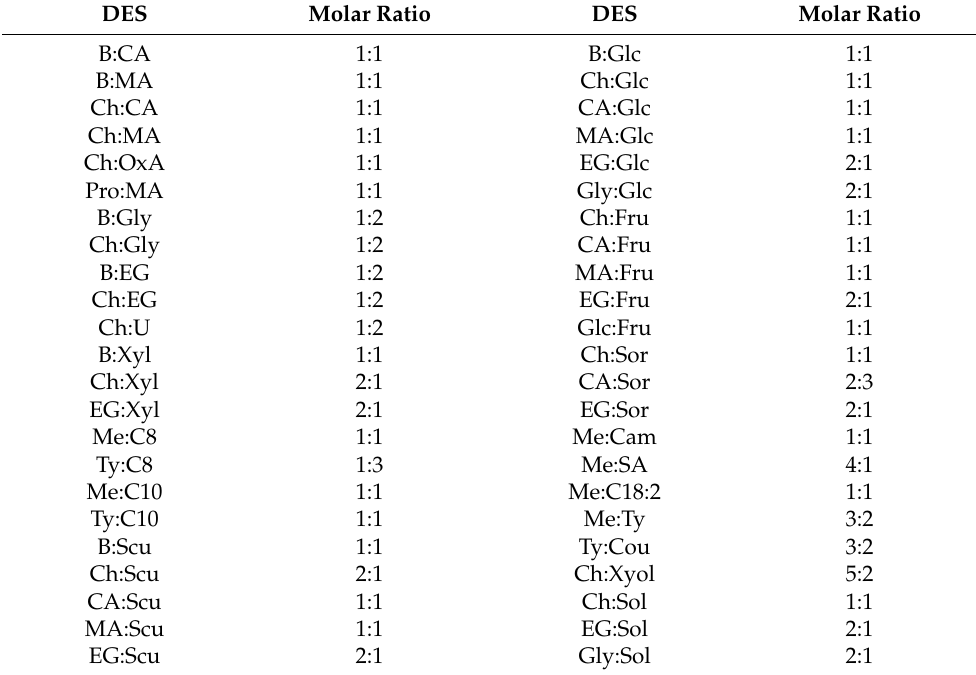
Table 1. Molar ratios of HBD and HBA in DES tested in COSMOtherm software for catechin solubility.